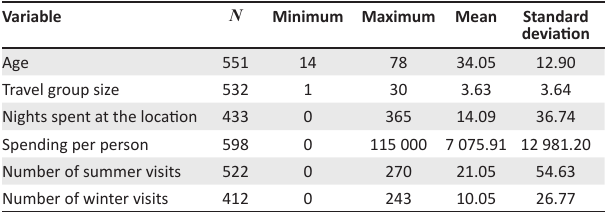
TABLE 1-A1: Summary statistics of the sample.